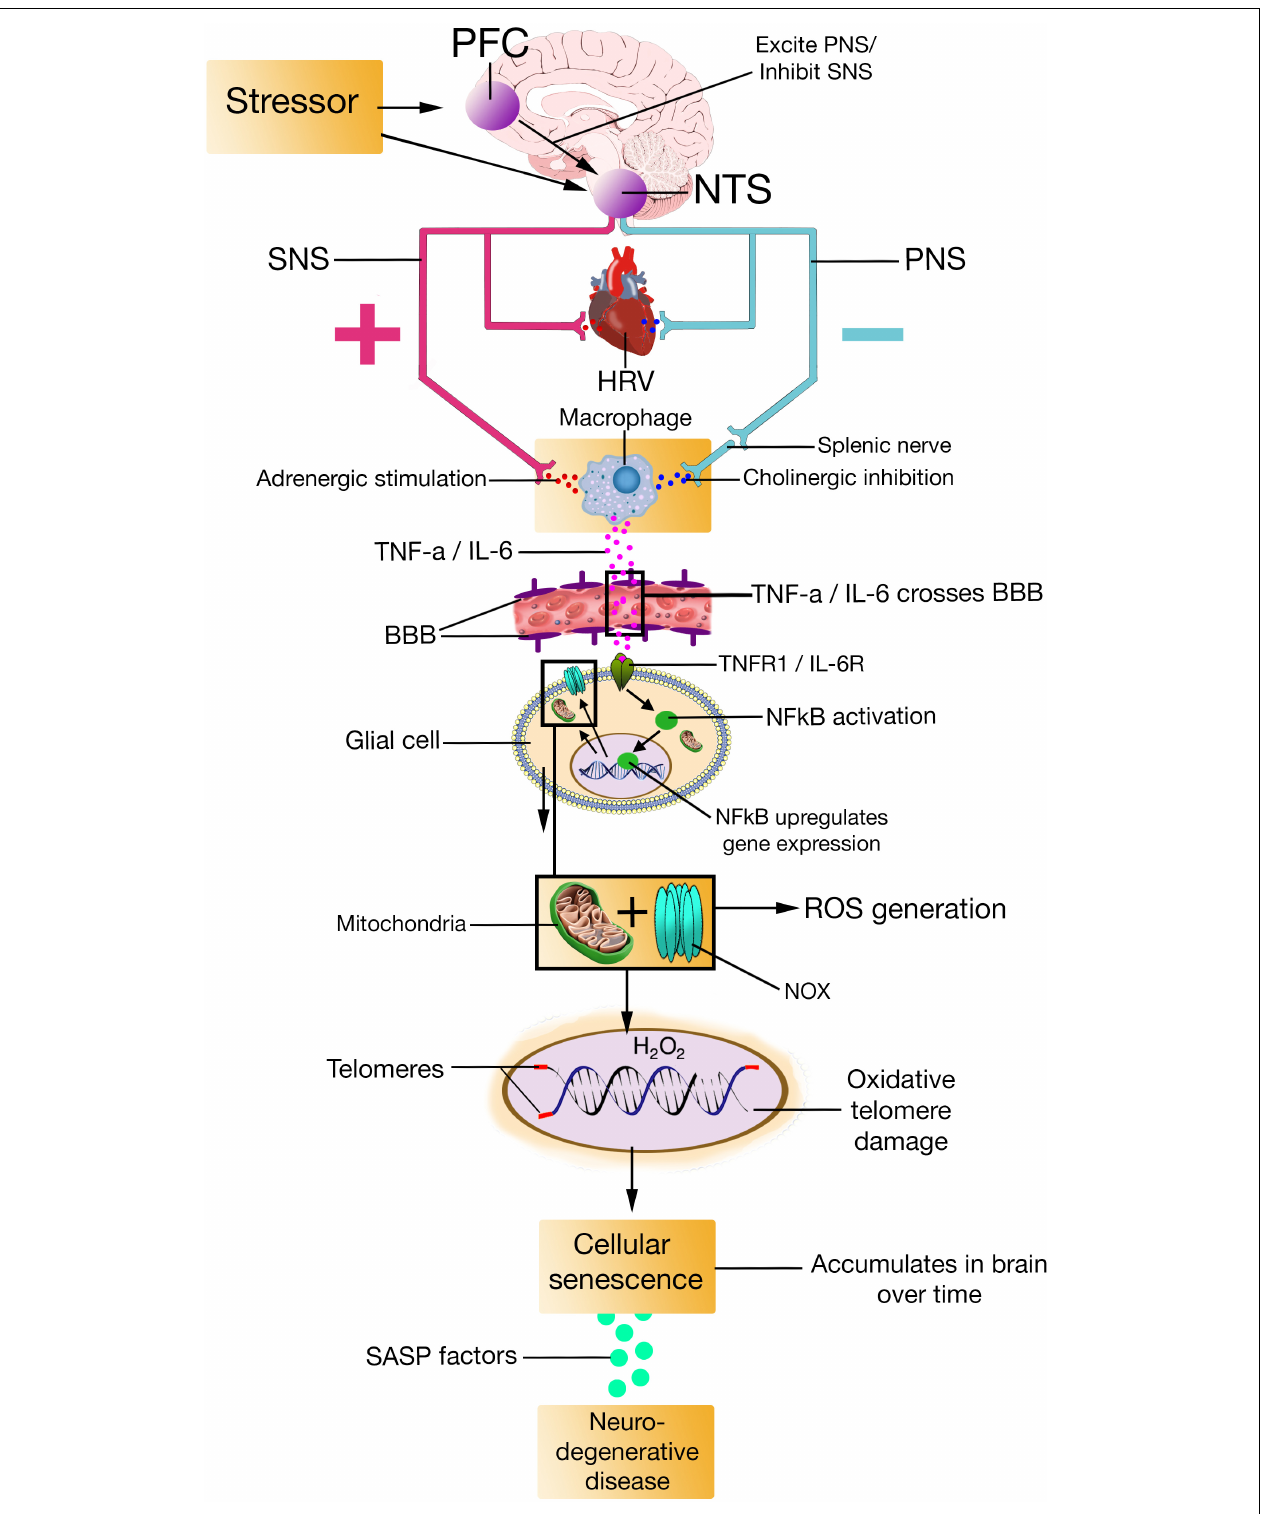
FIGURE 2 | PFC, prefrontal cortex; NTS, nucleus of the tractus solitarius; SNS, sympathetic nervous system; PNS, parasympathetic nervous system; HRV, heart rate variability; TNF-a, Tumor Necrosis Factor-alpha; IL-6, interleukin-6; TNFR1, Tumor Necrosis Factor-alpha Receptor 1; IL-6R, interleukin-6 receptor; BBB, blood-brain barrier; NFkB, Nuclear factor kappa light chain enhancer of activated B cells; H2O2, hydrogen peroxide; ROS, reactive oxygen species; NOX, nicotinamide adenine dinucleotide phosphate oxidase; SASP, senescence-associated secretory phenotype.